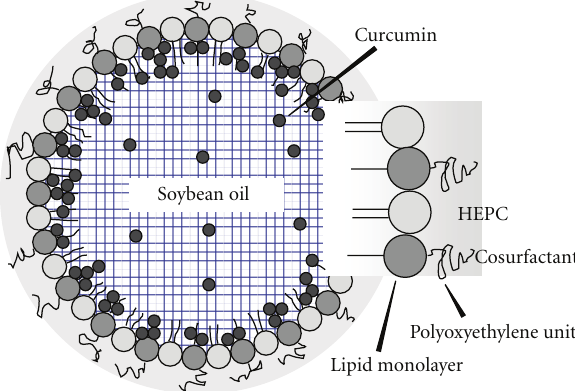
Figure 10: Schematic drawing of the particle structure of the curcumin-loaded lipid